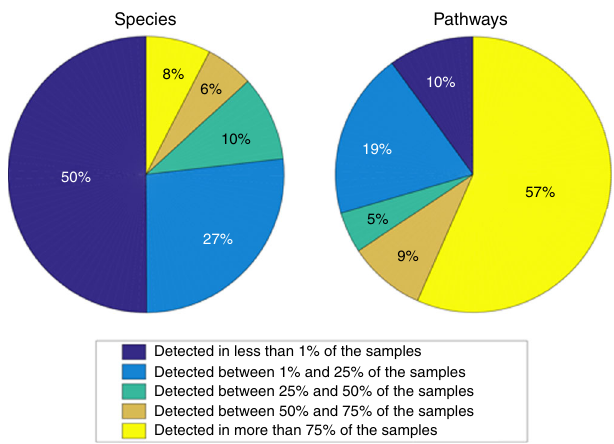
Fig. 1 Gut microbiome composition. The composition of the gut ecosystem is unique to an individual while its functionality is maintained across the population. Pie charts represent the percentage of species (on the left) and microbial metabolic pathways (on the right) present in <1% of the population (dark blue), between 1% and 25% (light blue), between 25% and 50% (turquoise), between 50% and 75% (brown), and more than 75%